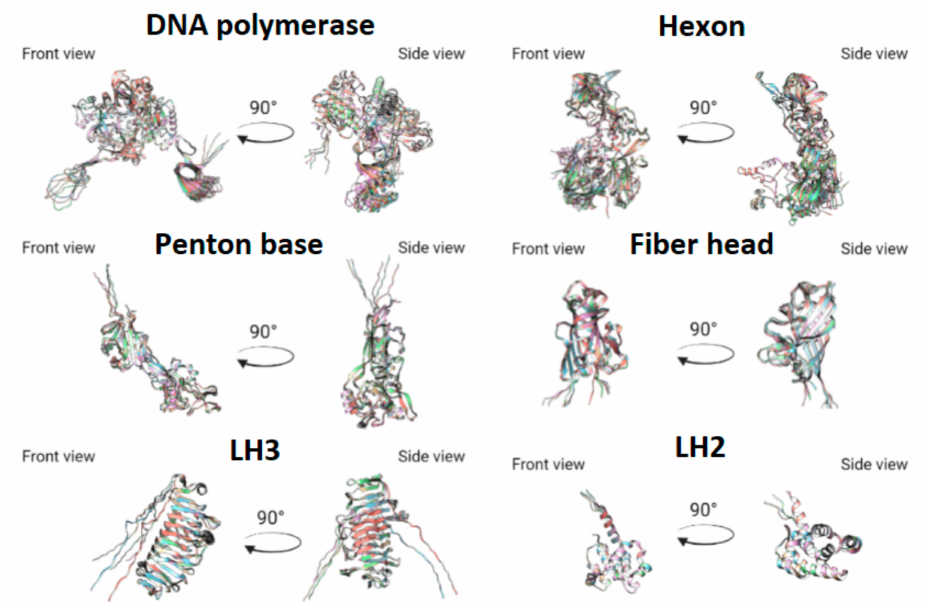
Figure 5. Comparison for predicted proteins 3D structures. For convenience, different colors were used for each predicted structure.